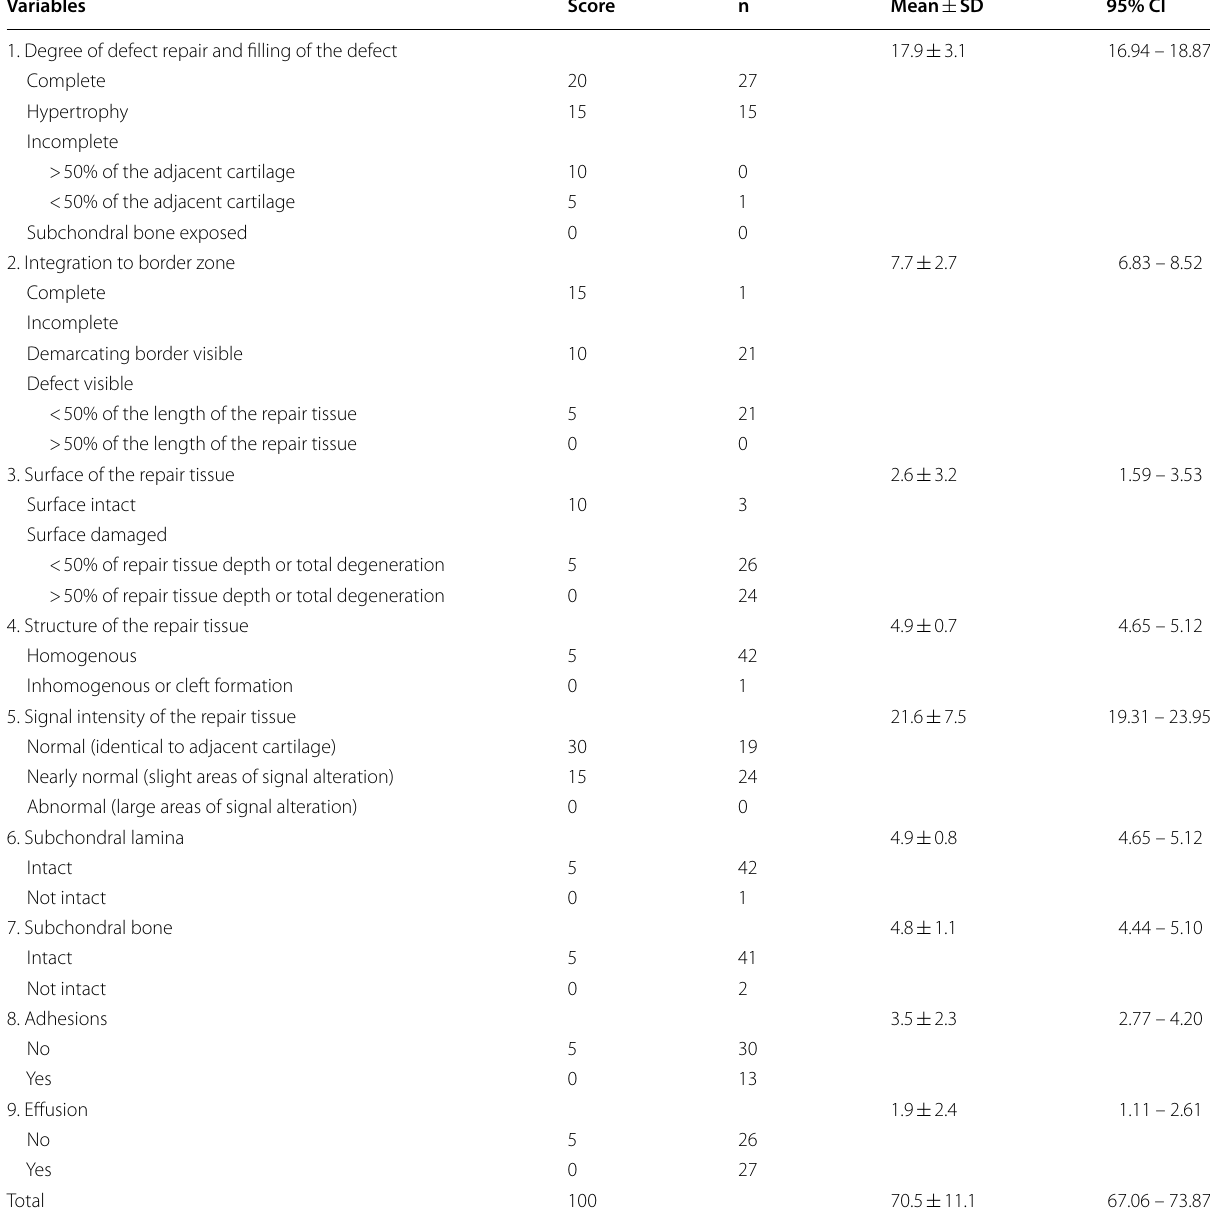
Data are presented as means standard deviation (SD) unless otherwise indicated ± MOCART Magnetic Resonance Observation of Cartilage Repair Tissue, MRI Magnetic resonance imaging, SD Standard deviation, CI Confidence